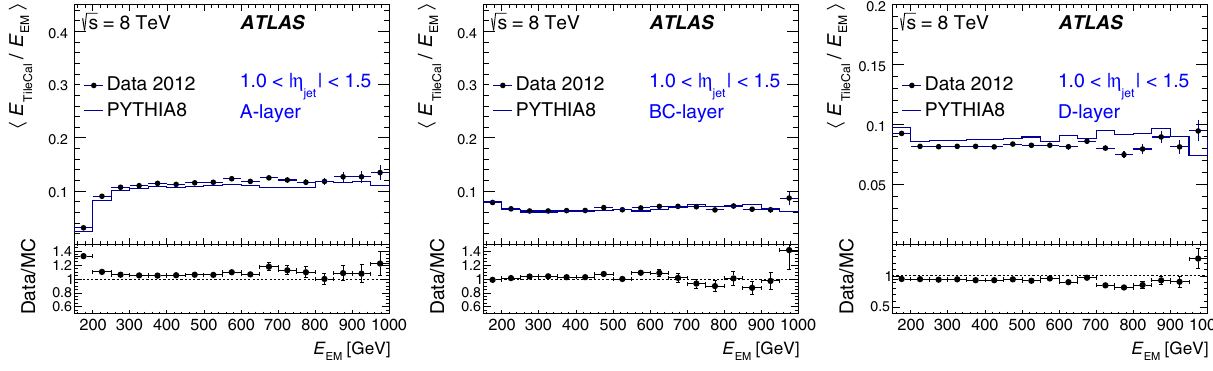
Fig. 26 Electromagnetic scale jet energy fraction in the TileCal for jets with p T > 140GeV in the extended barrel (1 . 0 < | η jet | < 1 . 5) for layer A (left), layer BC (middle), and layer D (right). Error bars represent statistical uncertainties